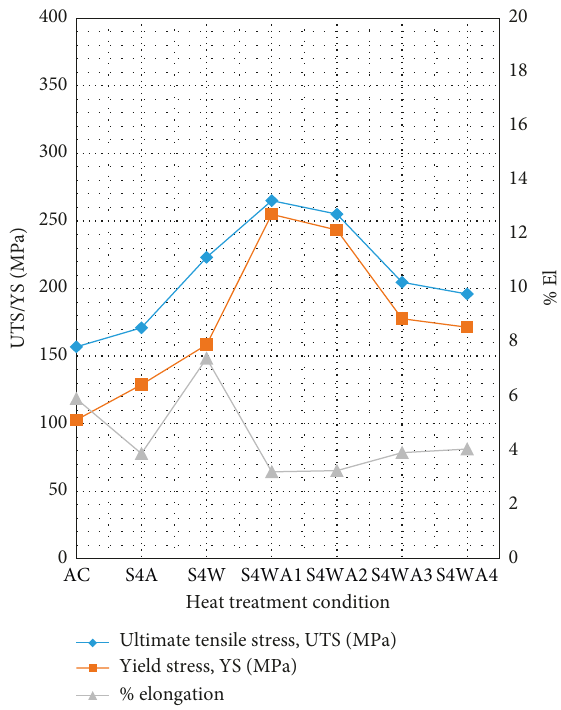
Figure 3: Average values of UTS, YS, %El for alloy C in the as-cast condition, and after heat treatments comprising SHTfor 4h (tested at 250 °